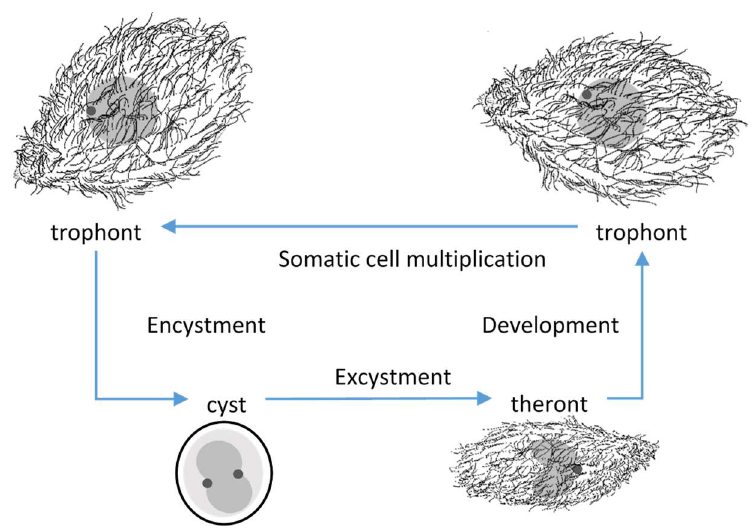
Figure 1. Simplified schematic of the Tetrahymena rostrata lifecycle showing trophonts, cysts and theronts, which are distinguished by their cellular morphology and the arrangement of the macronucleus (grey) and small micronucleus (dark grey).